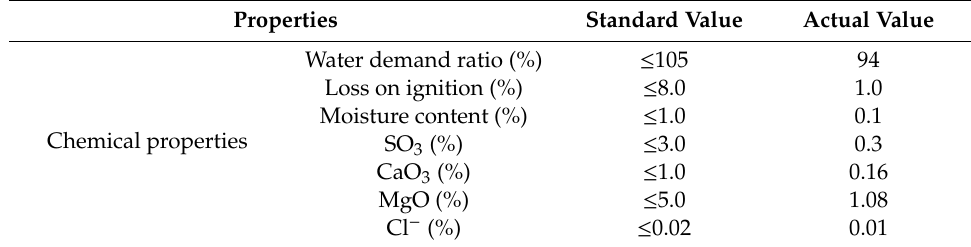
Table 3. Chemical properties of fly ash.